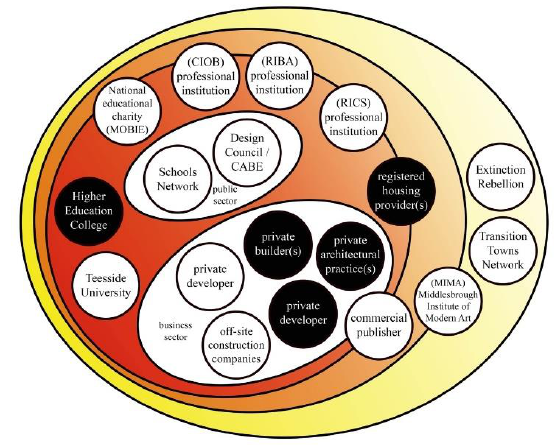
Figure 14. Mapping of Future Homes Postgraduate Level 7 Module.